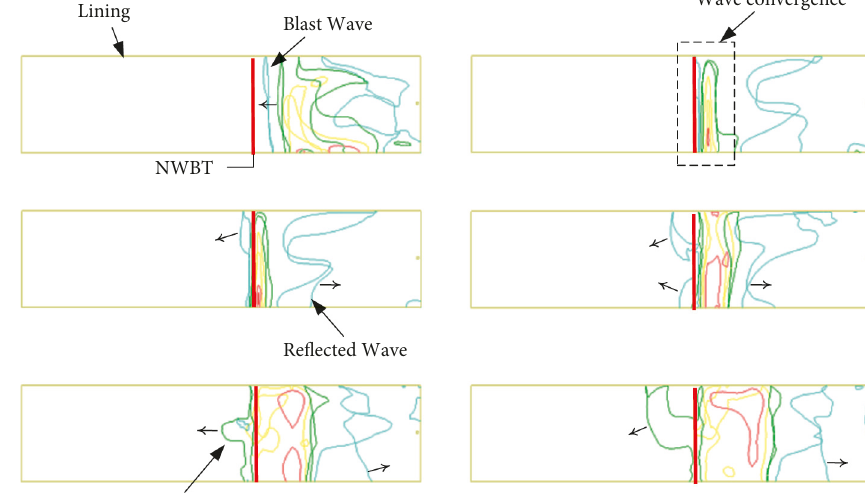
Figure 17: Blast wavefront near rigid wall and wave-blocking curtain.